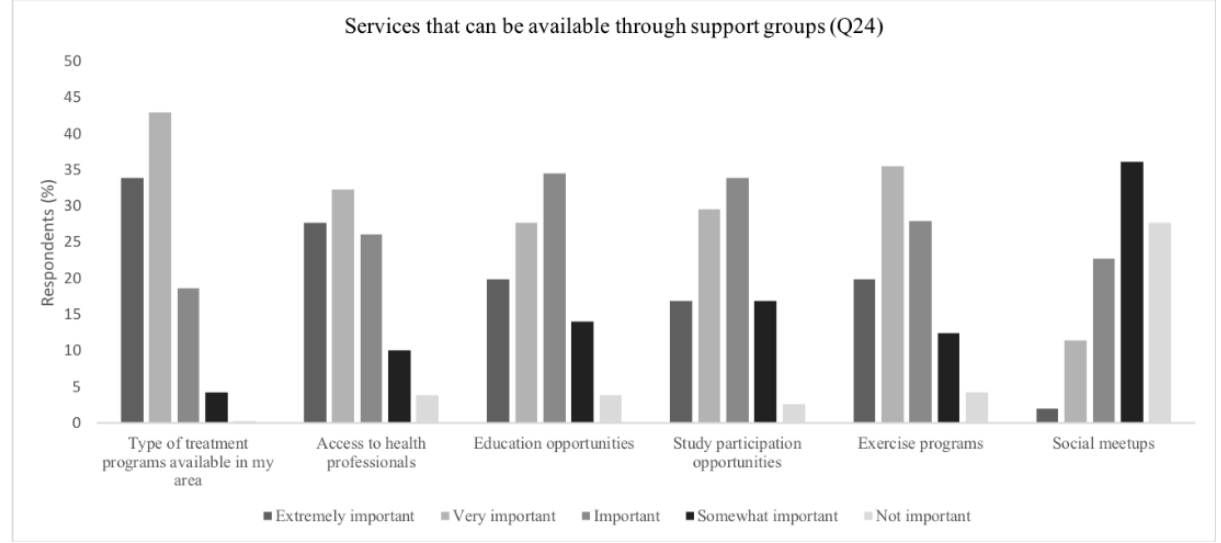
Figure 3. Preferences on service distribution for Yes–support